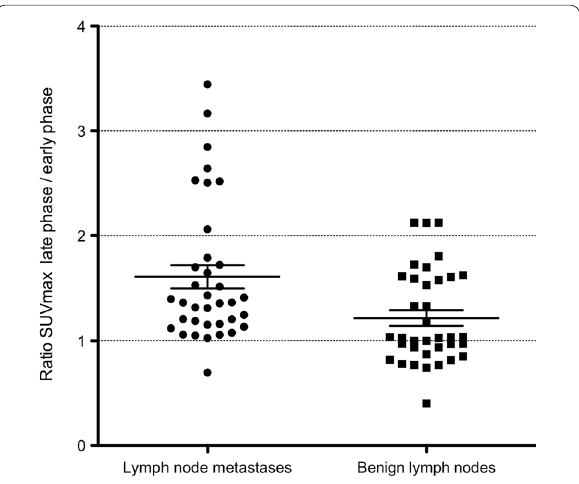
Fig. 3 Late-phase/early-phase SUVmax ratio of lymph node metastases versus benign lymph